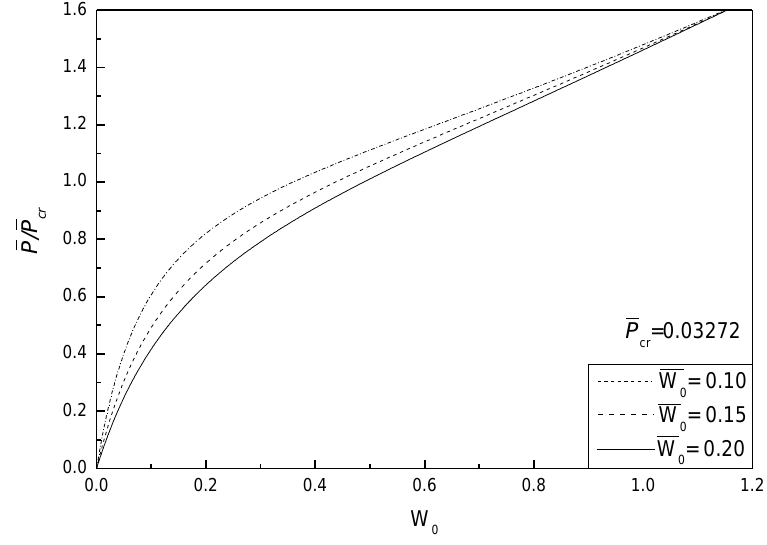
Figure 7. Effect of initial geometric deflections on the postbuckling response curves of piezoelectric plate without damage.